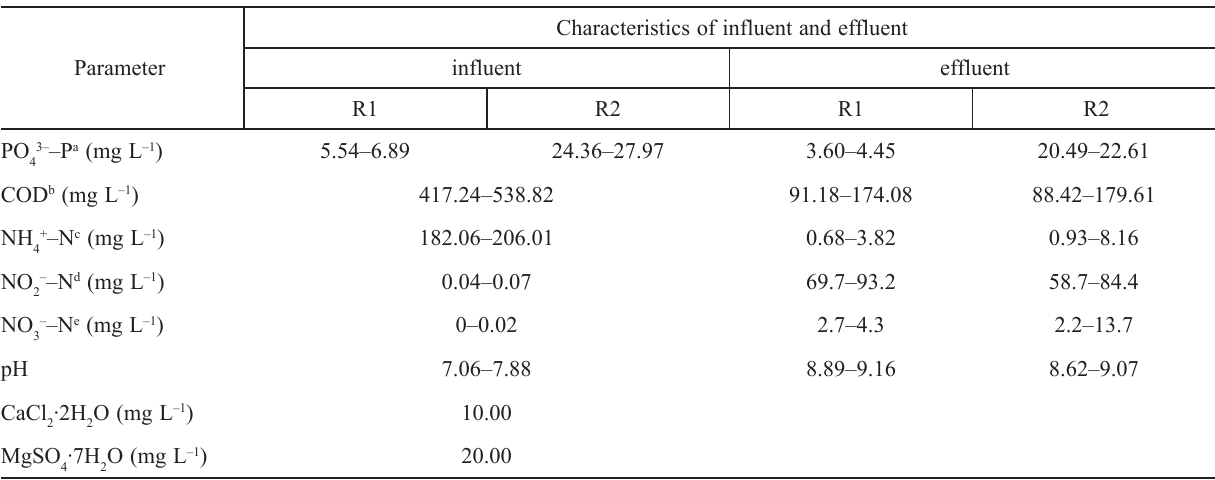
Table 1 – Characteristics of influent and effluent of AGS reactors R1 and